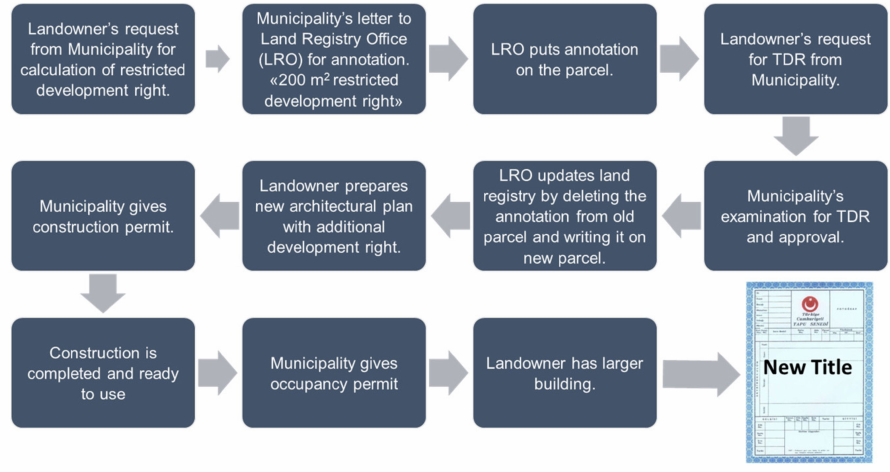
Figure 7. The overview of the proposed TDR